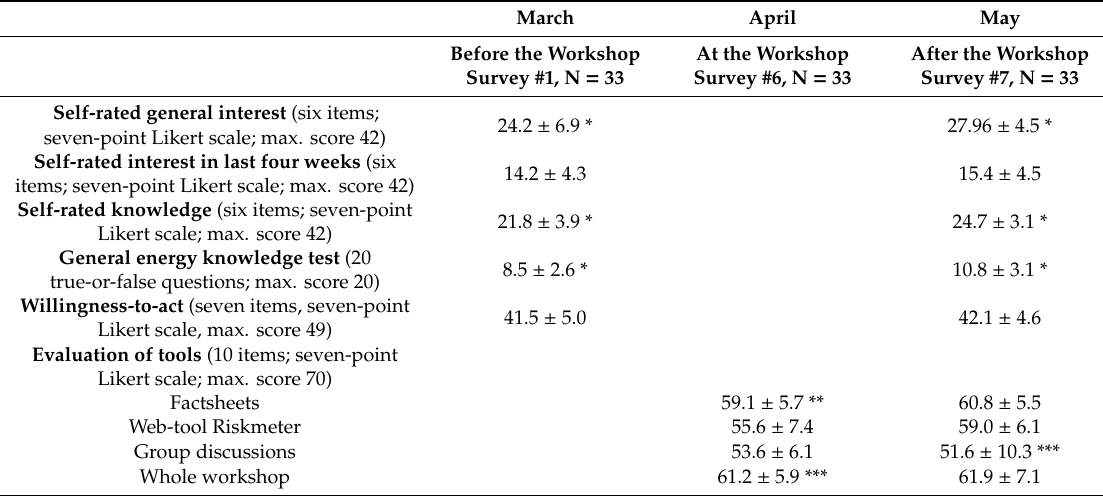
Table 1. Average evaluations of informational materials in the city of